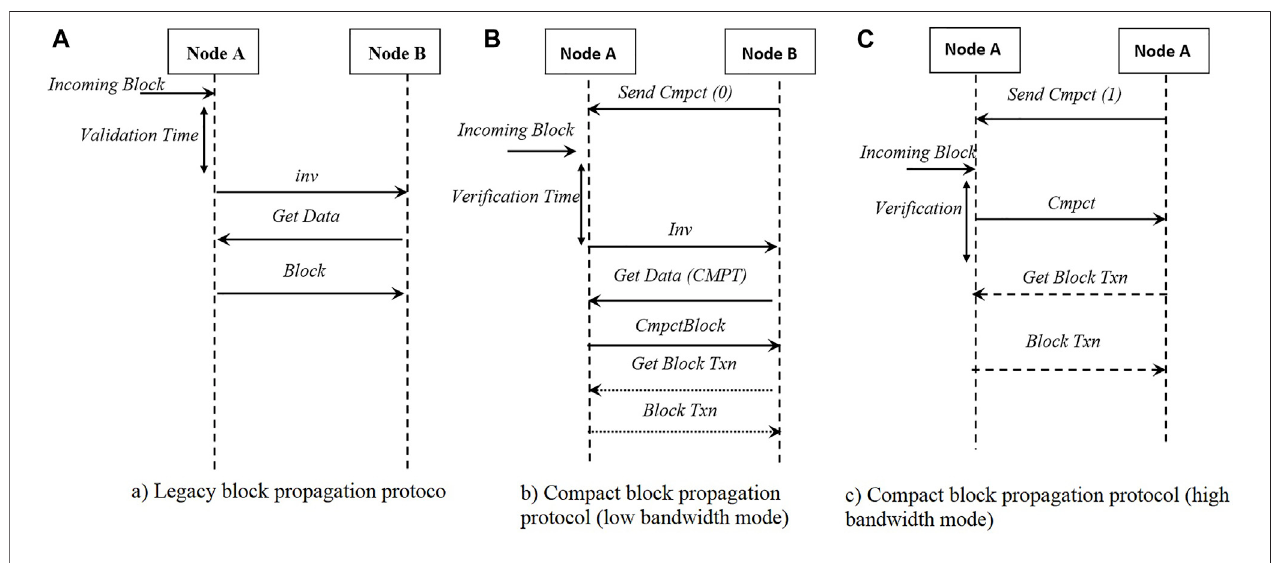
FIGURE 2 | Block propagation protocol in Bitcoin